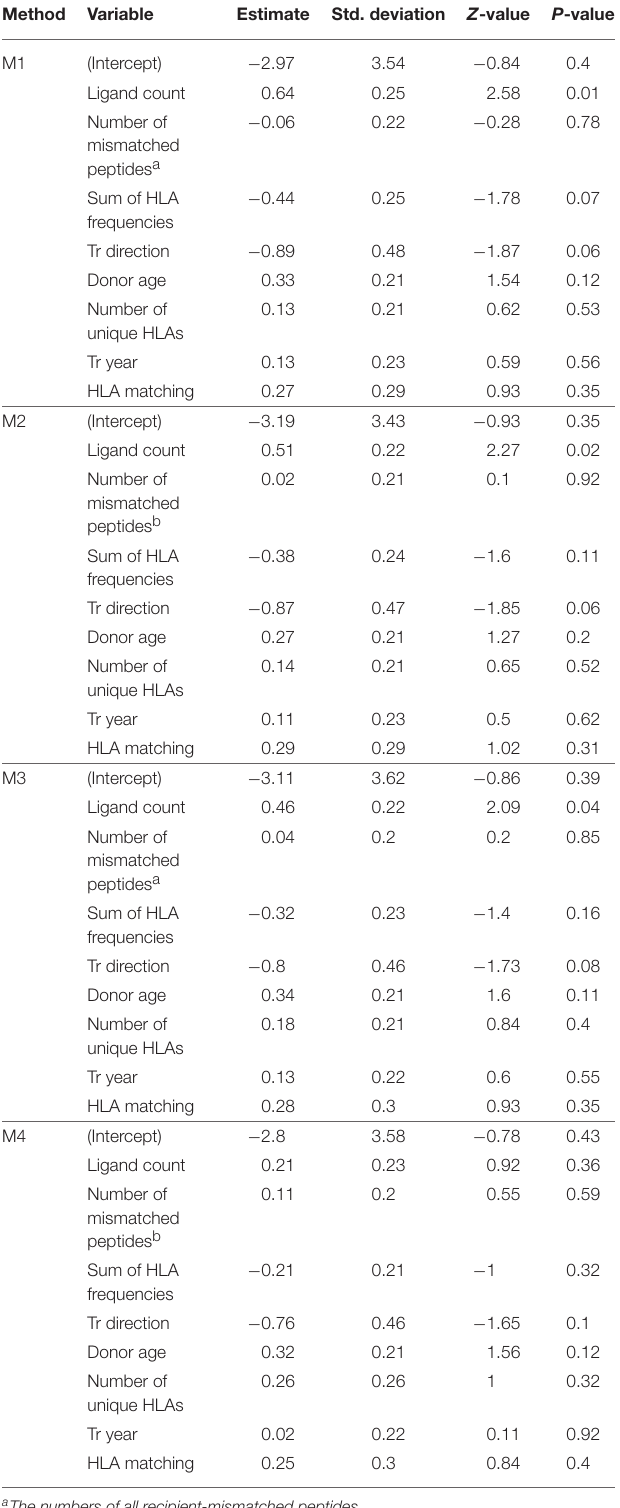
TABLE 3 | Logistic regression results for chronic GvHD by analysis methods M1–M4. Method